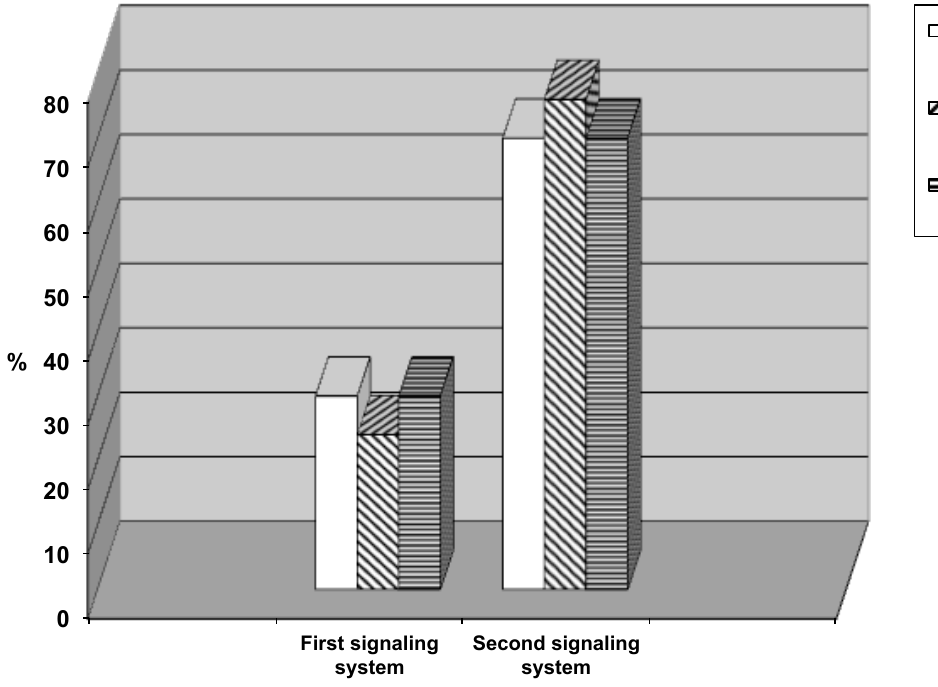
Fig. 1. Correlation of both signalling systems in students of different learning domains (in percentage) Table 1. Properties of psychomotor, intellectual, and communicative fields in students of different domains of physical education and sports (in points, mean, standard